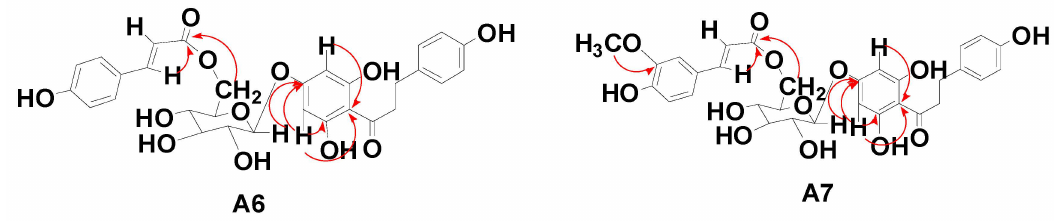
Figure 2. Main 1 H- 1 H COSY and HMBC correlations of A6 and A7